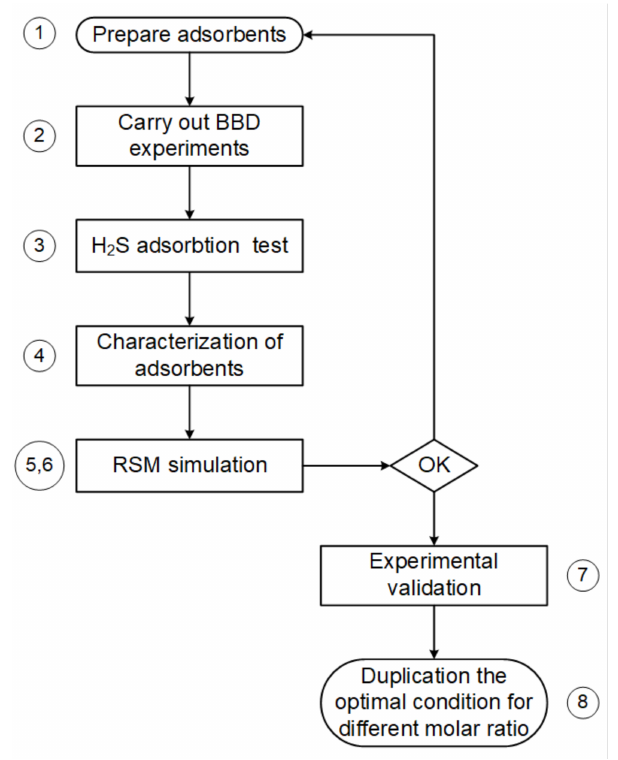
Figure 2. Process